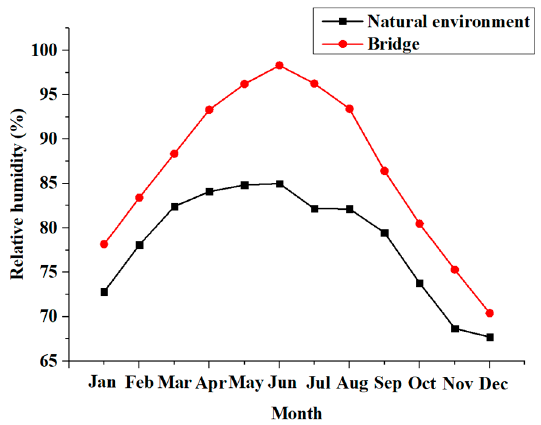
Figure 8. Annual humidity cycle.